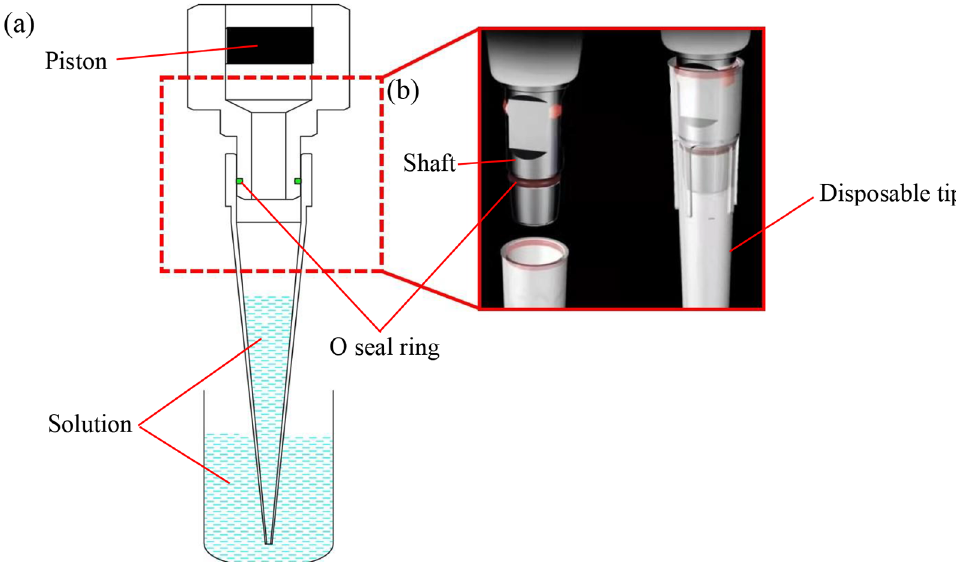
Fig. 1. The process of and pipette shaft and disposable tip assembly. (a) Diagrammatic fi gure of pipette device (b) Pipette shaft and disposable tip before assembly (c) Assembly